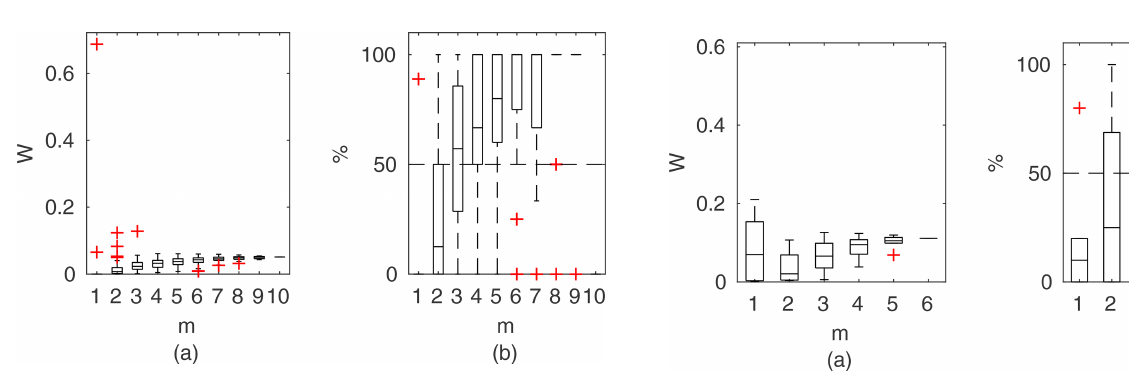
Figure B12. GTLM results for the Ritobacken case study, spring 2011: (a) averaged relative confidence widths W as a function of observation set size m used for model identification; (b) percentage of verification points enclosed by the confidence intervals (100% denotes all points within intervals, box spans over the 25% and 75% quantiles, the median is given with horizontal line, whiskers indicate the result extent, and cross marks are for extreme